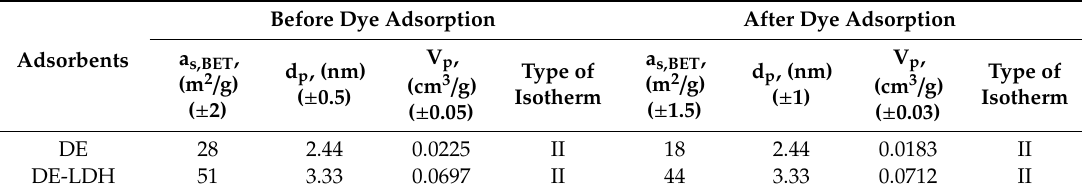
Table 1. Surface area and porosity measurement of adsorbents.